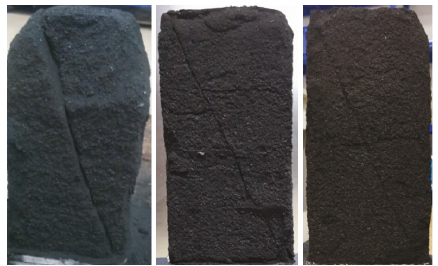
Figure 8: Specimens after shear seepage